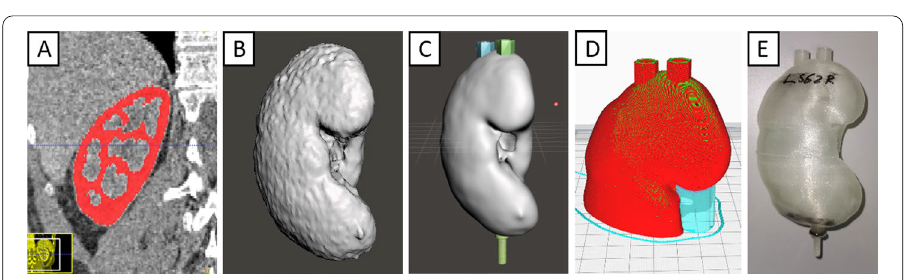
Fig. 2 Graphical representation of the workflow for creating kidney phantoms. Workflow for creating a kidney phantom. A Segmentation, B segmented model, C modified model, D half phantom for printing, E kidney